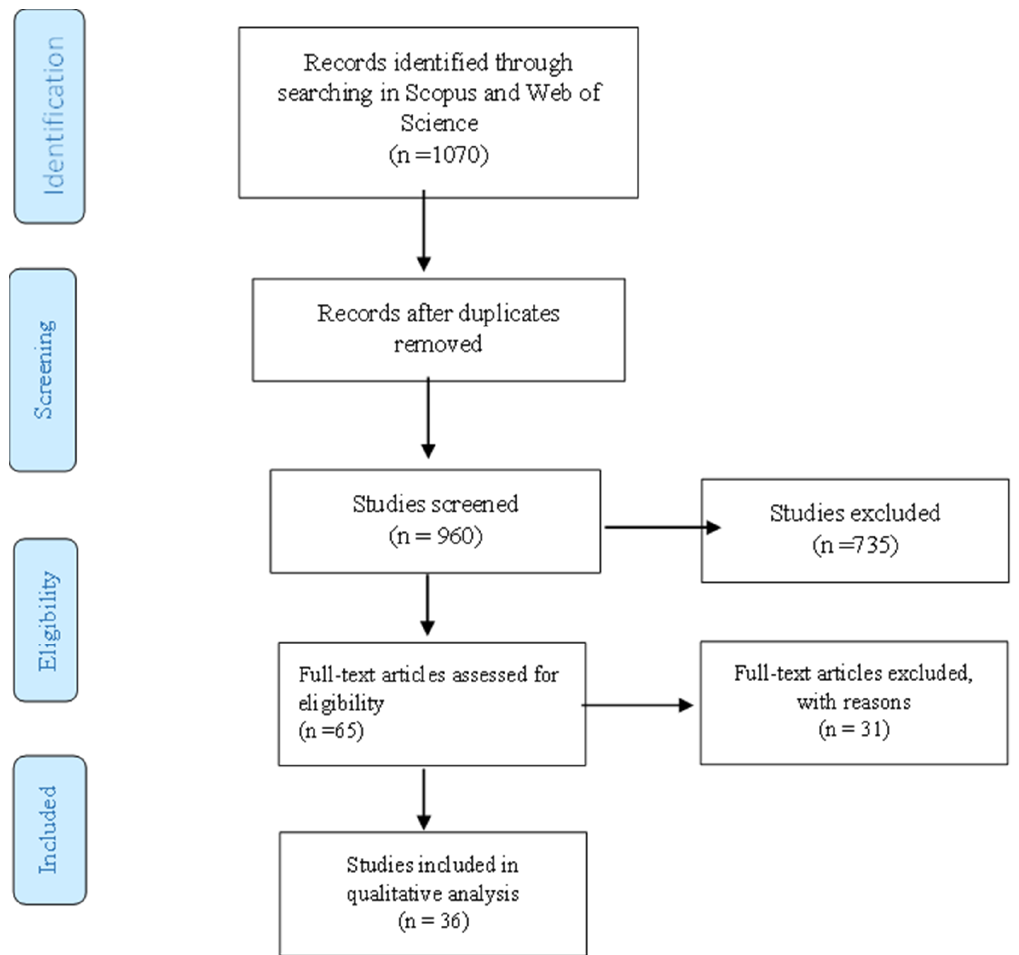
Figure 1. PRISMA flow diagram detailing steps in the identification and screening of sources (Moher et al. 2010).